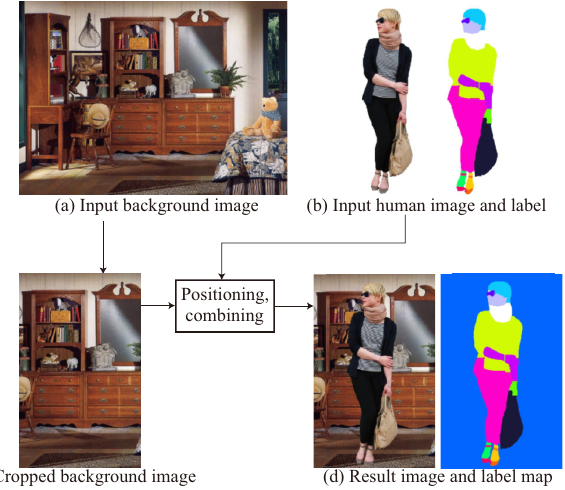
Fig. 2 Background augmentation procedure.